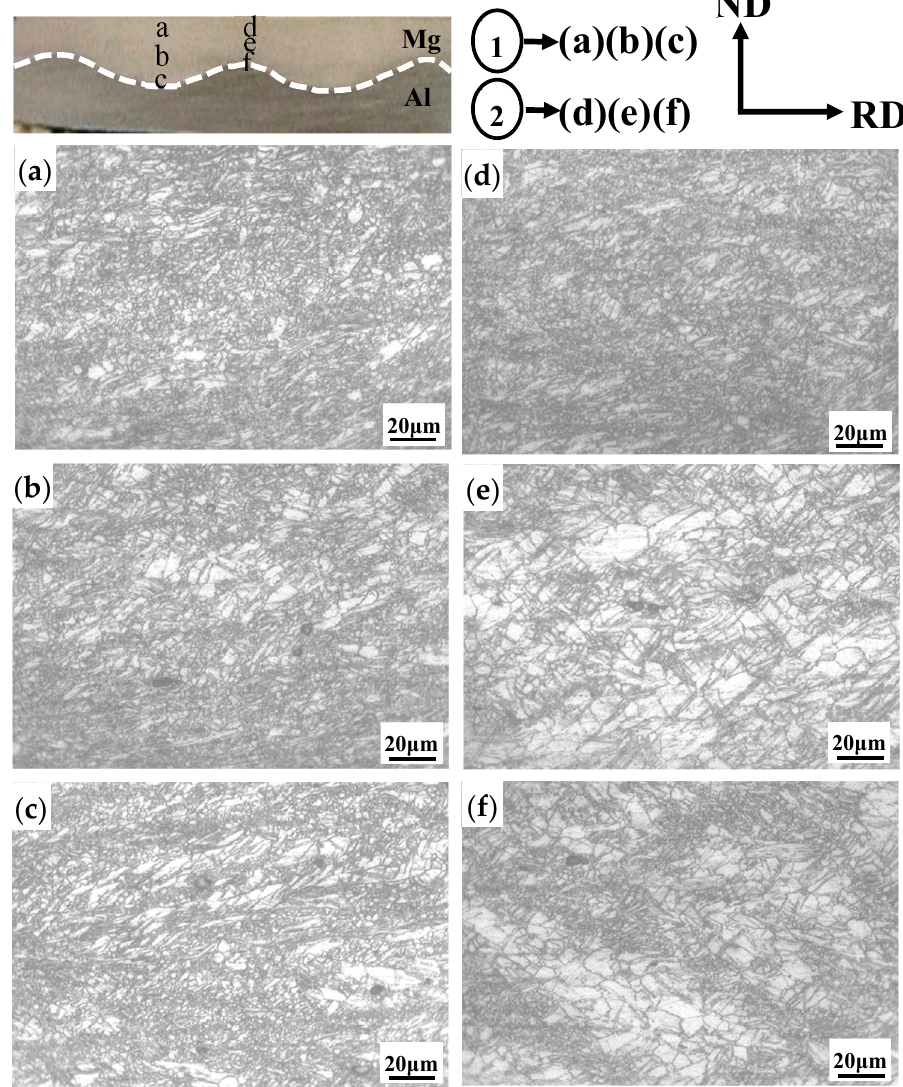
Figure 10. Microstructure of the AZ31B of as-rolled CFR Mg/Al laminated composite. ( a – c ) Position 1; and ( d – f ) position 2.